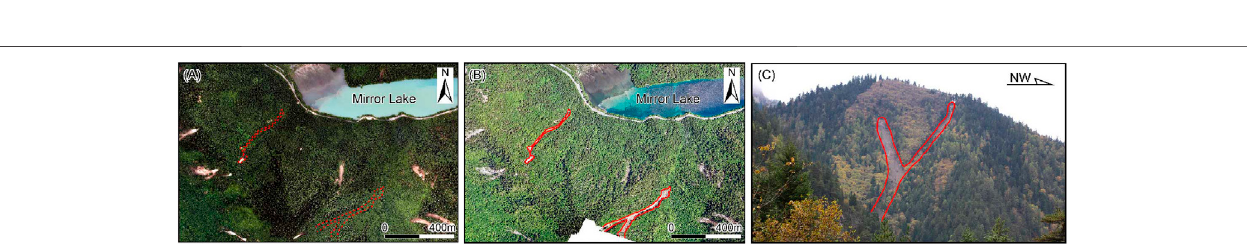
Frontiers in Earth Science |